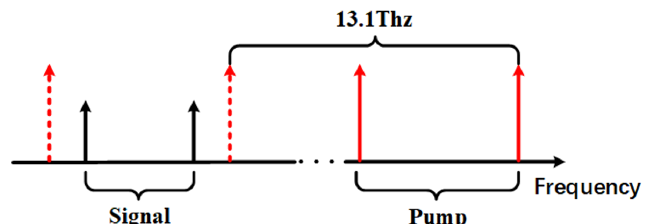
Figure 8. The relationship between bands of signal and pump.